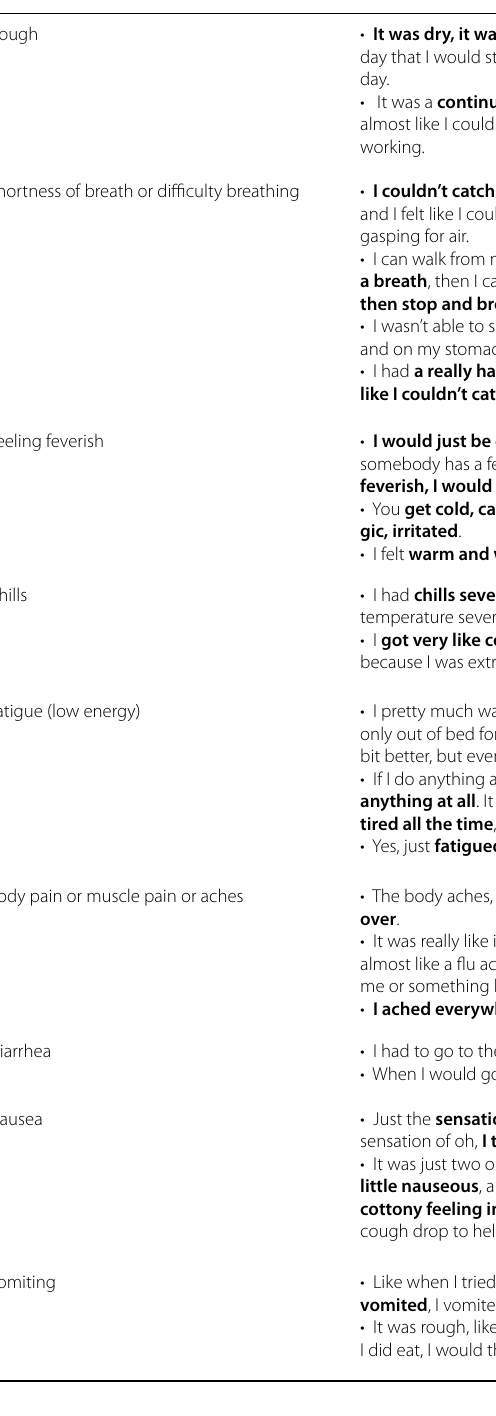
Table 3 Selected Quotations: Patients’ Descriptions of Common COVID-19 Symptoms Symptom Selected